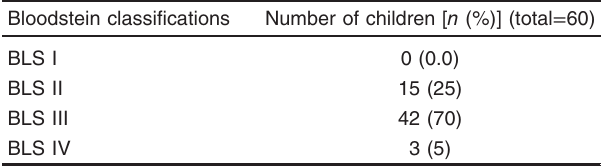
Table 5 Number and percentage of participating children in each degree of Bloodstein classification Bloodstein classifications Number of children [ n (%)] (total = 60)